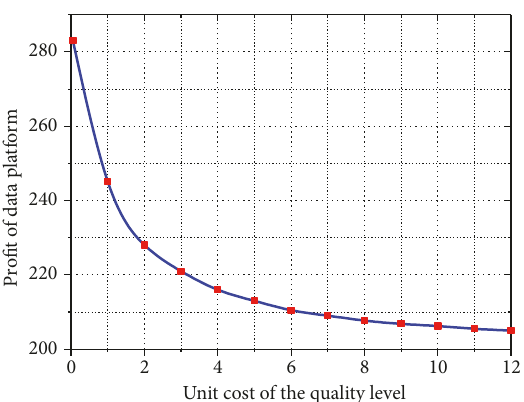
Figure 6: Data platform profit under different subscription fees.